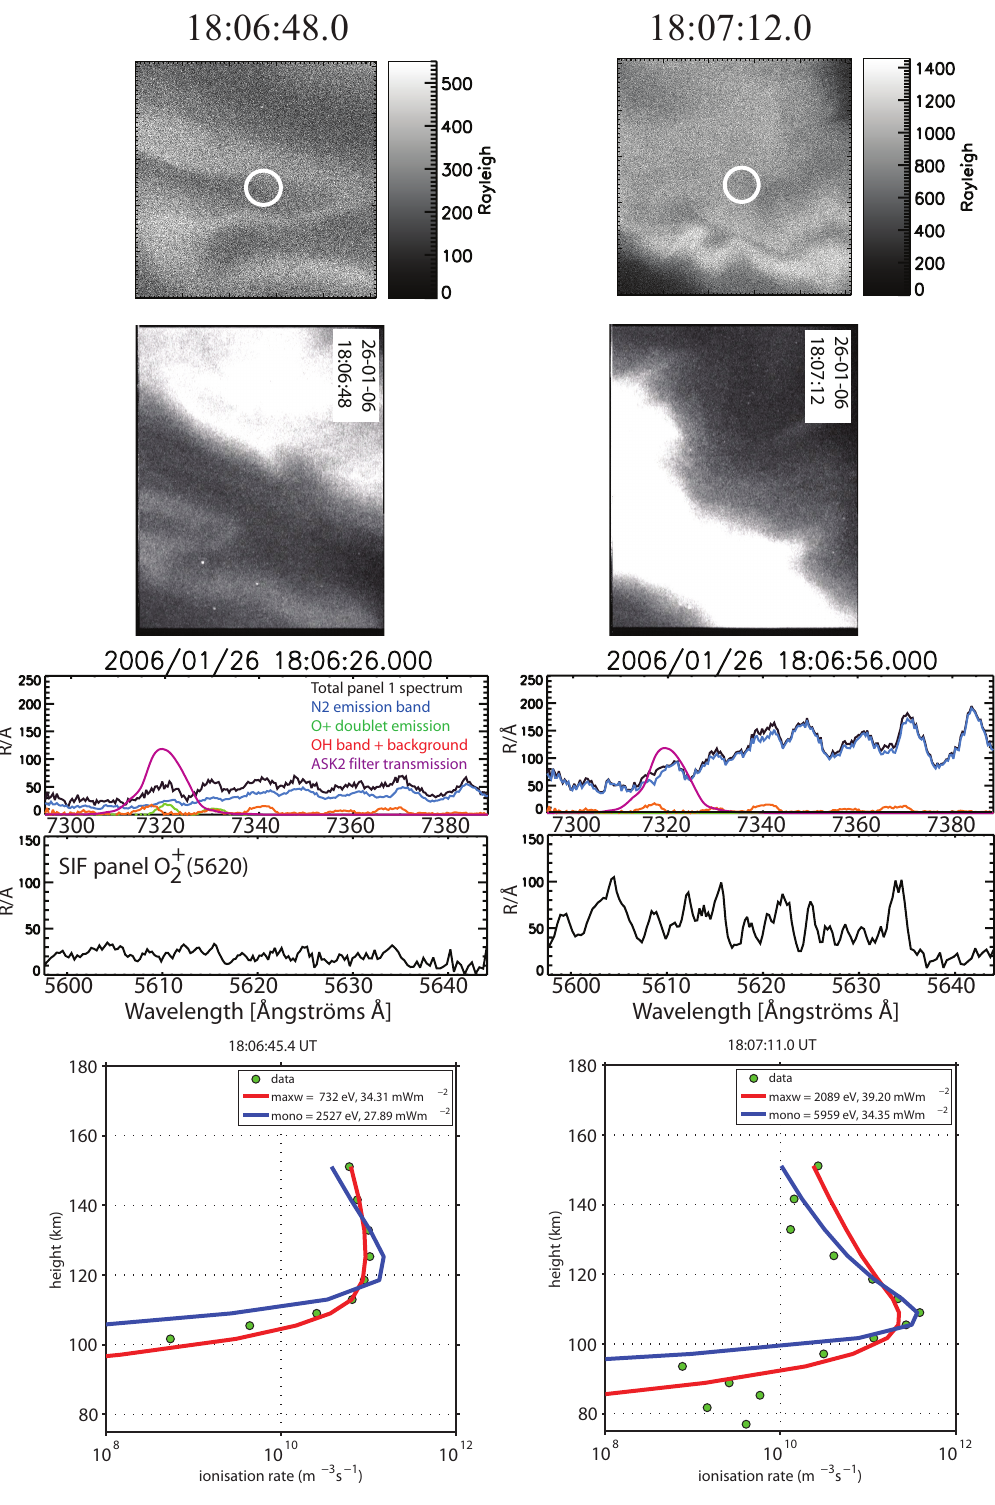
Fig. 8. Event 3: Optical and electron density data from 18:06UT. The top row shows ASK3 images, the second row SIF video camera images, the third and fourth rows the SIF spectra. The bottom row are ionisation rate profiles derived from the ESR electron density profiles, and best fit model profiles with assumed Maxwellian and monoenergetic energy